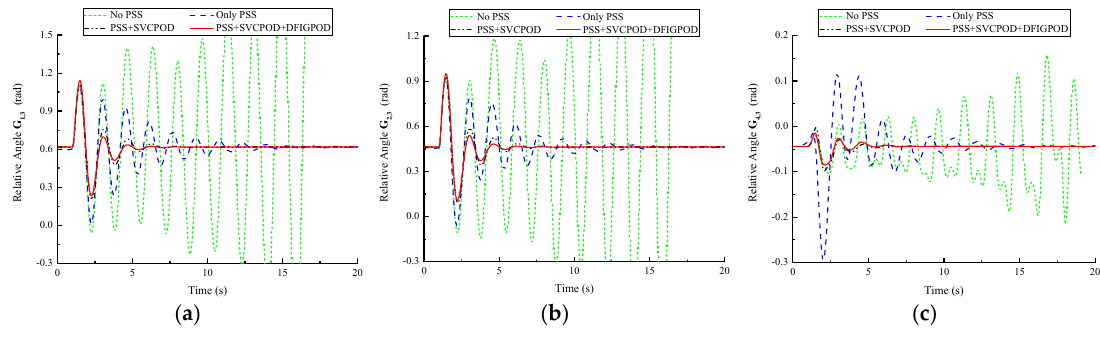
Figure 11. System bus 7 3-phase fault responses under normal inter-area power flow transmission condition. ( a ) Relative power angle of generator G1 and G3; ( b ) Relative power angle of generator G2 and G3; and ( c ) Relative power angle of generator G4 and G3.